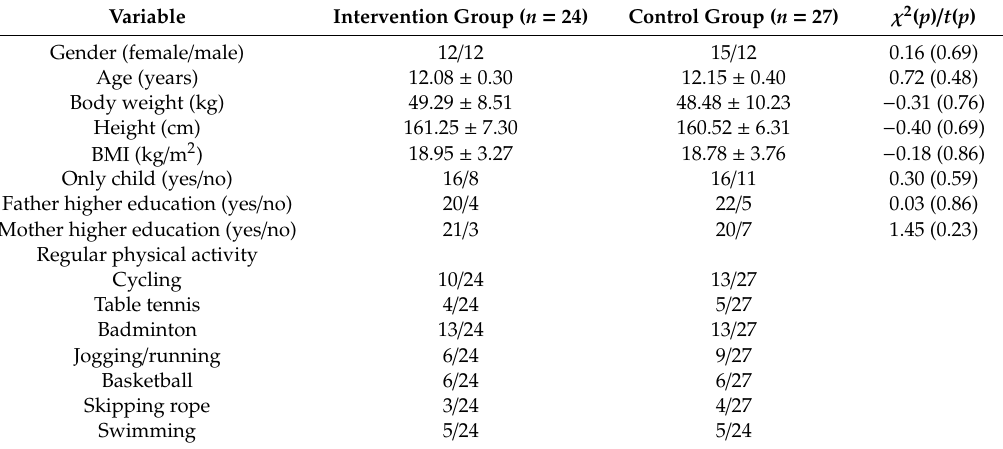
Table 2. Demographics of participants at baseline ( n =